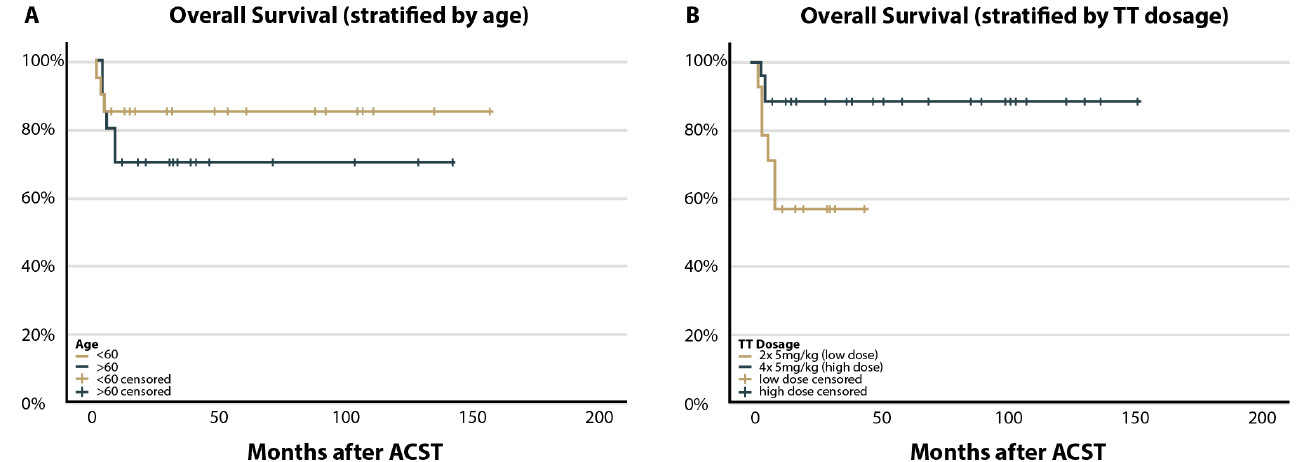
Figure 2. Overall survival (OS). X-axis: time of initial diagnosis until today. Y-axis: OS in %. Kaplan– Meier overall survival curve of PCNSL patients treated with high-dose chemotherapy followed by autologous stem cell transplantation (HDC/ASCT). ( A ): Stratified by age ( ≤ 60 years vs. >60 years) no significant differences in OS were observed ( p = 0.334). ( B ): Stratified by TT dosage (group 4 × 5 vs. 2 × 5mg/kg) a significant difference is seen in OS ( p ≤ 0.001).